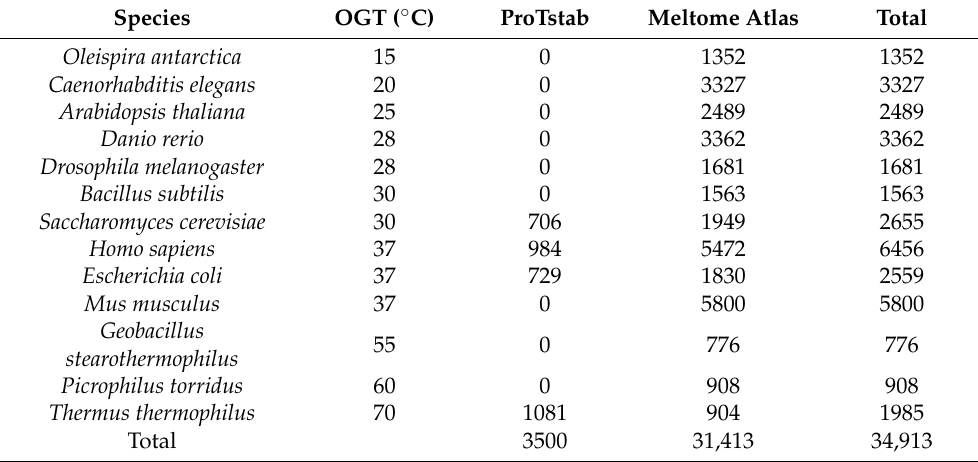
Table 1. Numbers of proteins in species and data sets used for method